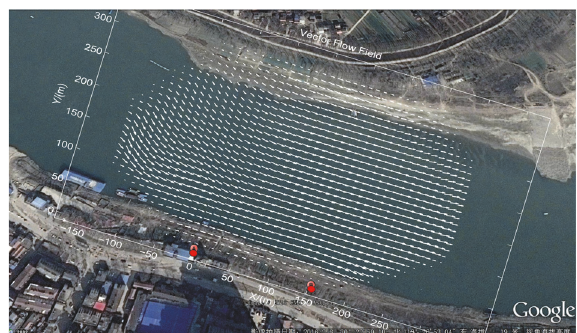
Figure 13: At 2016-7-24-7:05, two-dimensional flow pattern of the dual sites